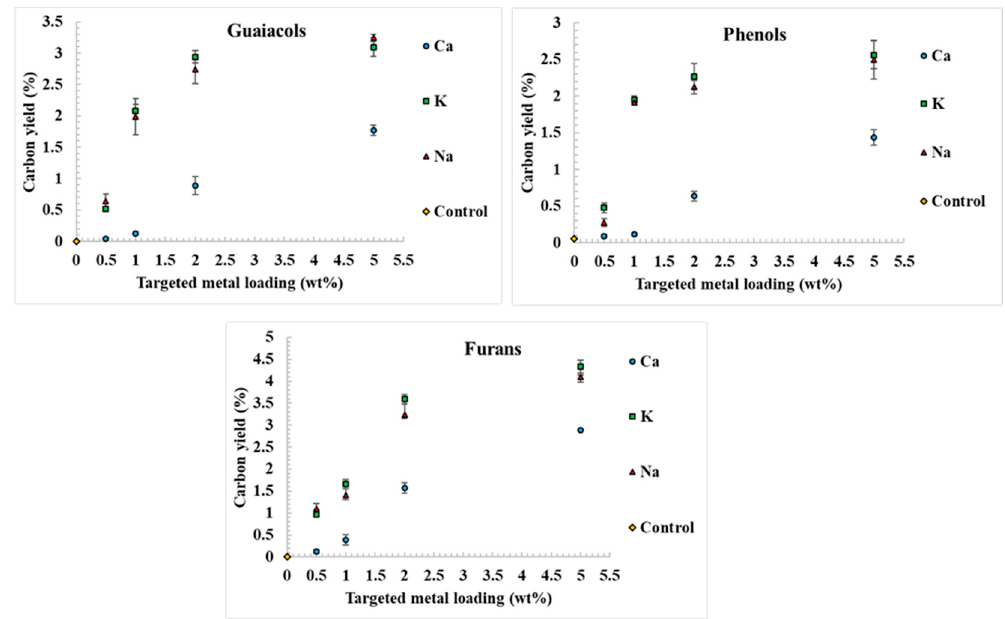
Figure 6. Yield of guaiacols, phenols and furans from in-situ CFP experiments with H+ZSM-5 catalysts deactivated by inorganics.